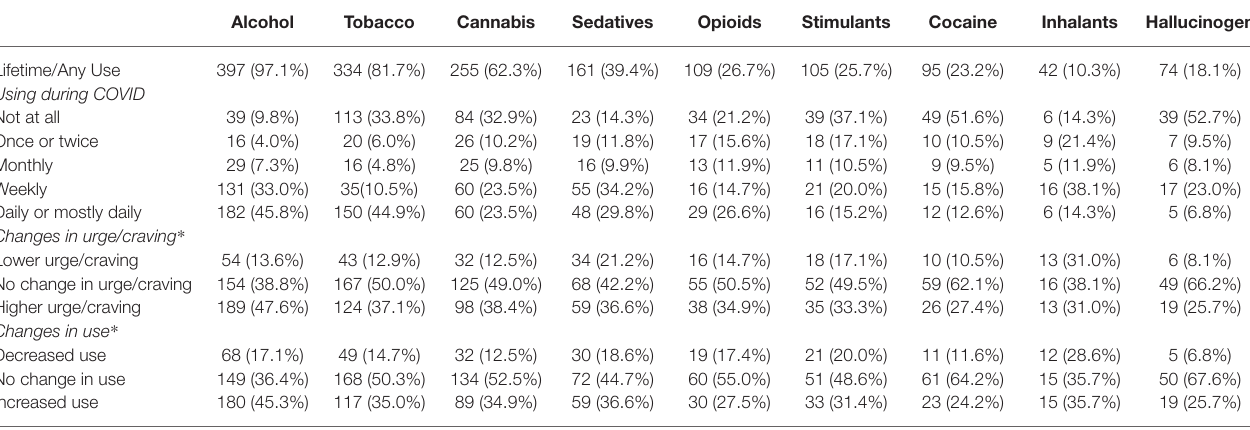
TABLE 3 | Alcohol and non-prescription substance use, urges, and changes in use due to COVID-19.